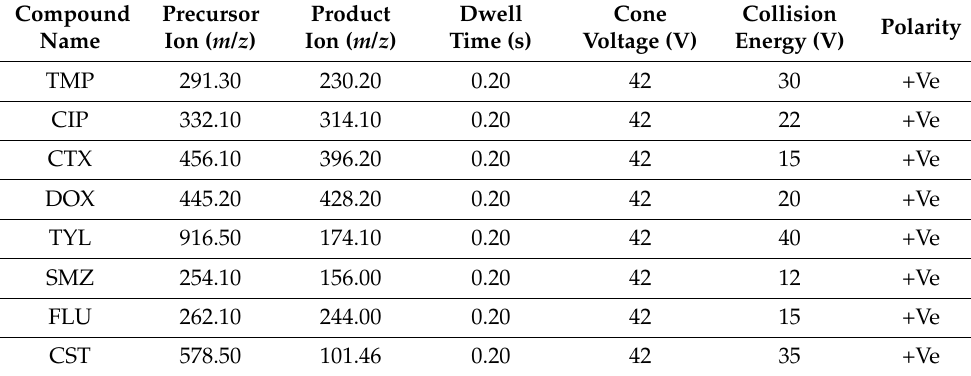
The mass spectrometry index for analytes monitoring is listed in Table 3. Table 3. LC-MS/MS parameters of monitoring the TMP, CIP, CTX, DOX, TYL, SMZ, FLU, and CST